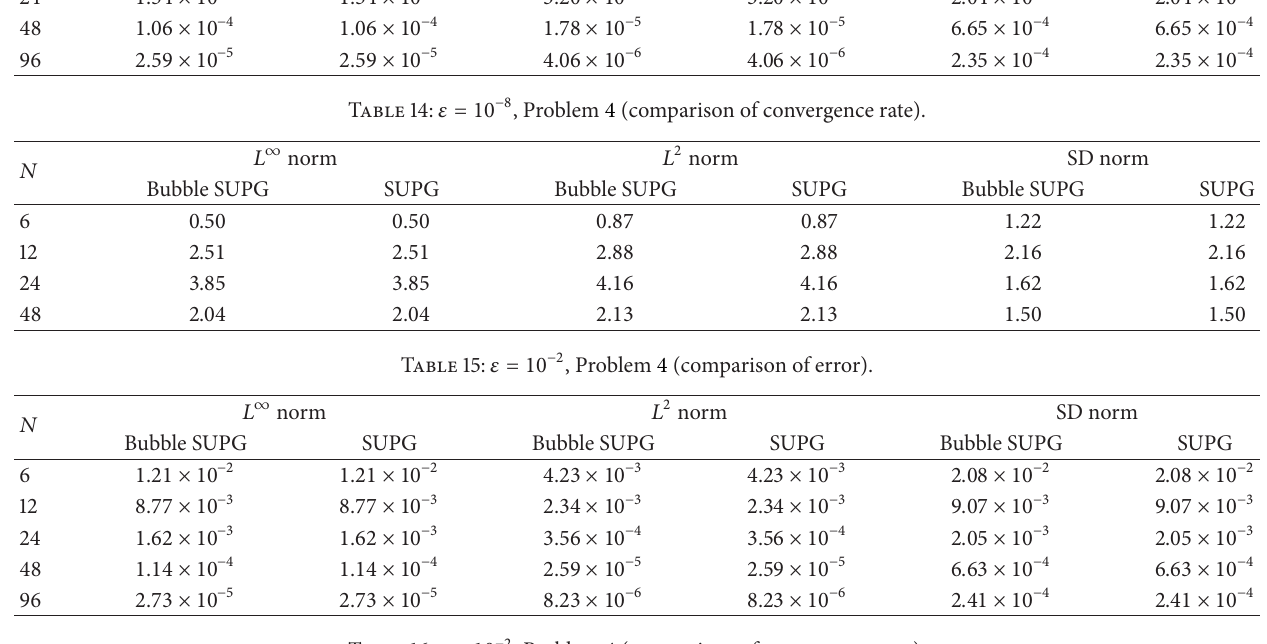
Table 16: 𝜀 = 10 −2 , Problem 4 (comparison of convergence rate).